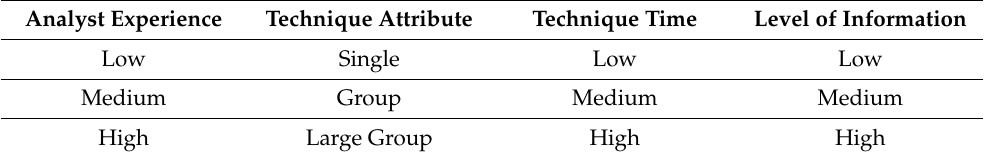
Table 2. Technique selection